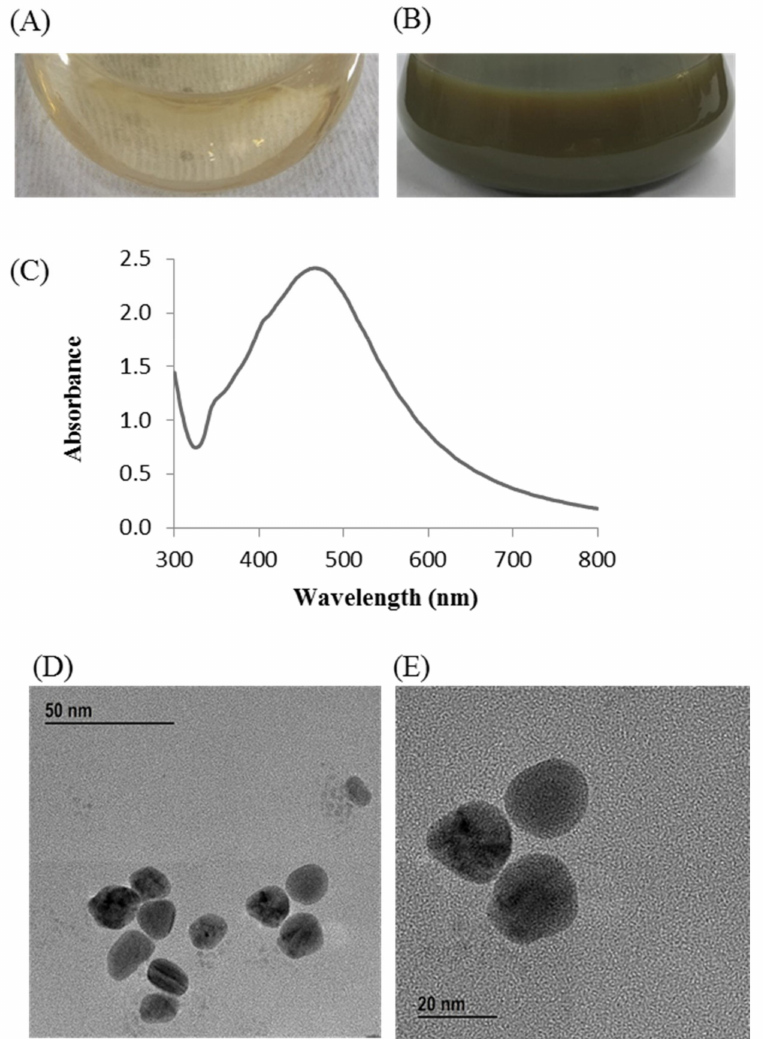
Figure 2. R2A broth with AgNO 3 as control ( A ), P. nicotinovorans MAHUQ-43-mediated synthesized